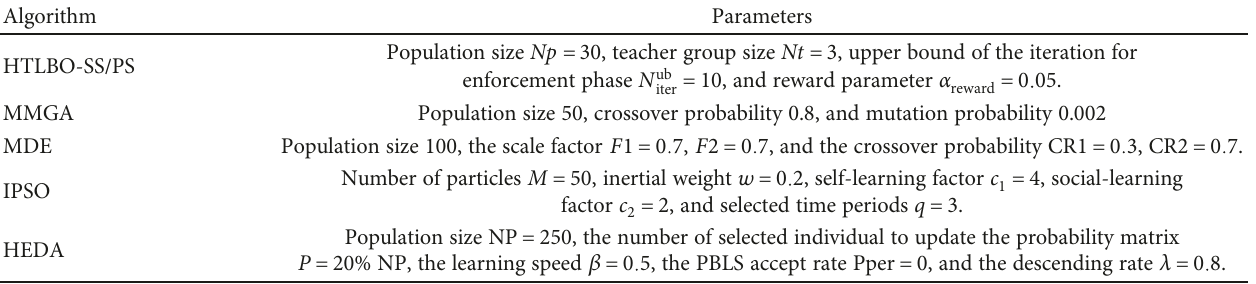
Table 10: Parameter settings of the algorithms. Algorithm Parameters